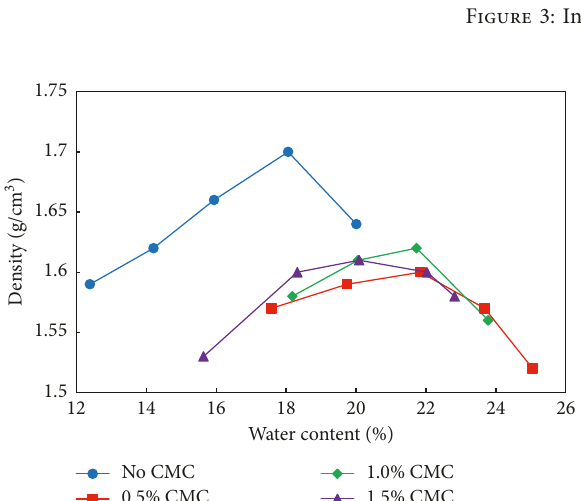
Figure 4: Moisture-density relation for CMC-stabilized soil.